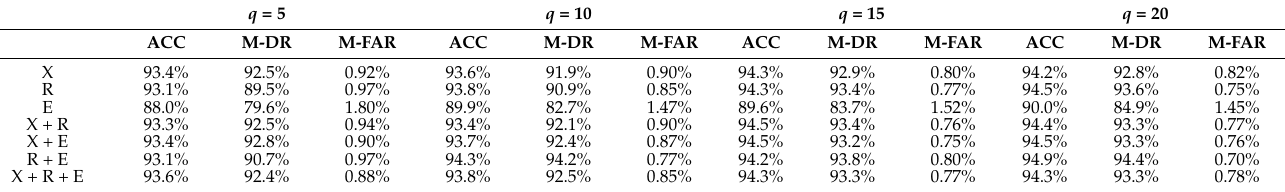
Table 9. Results of nine-class classification with different CaForest structures.